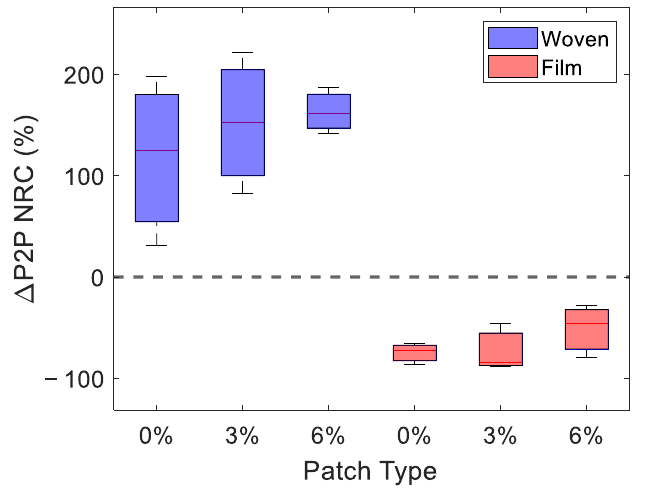
Figure 7. A box plot of the NRC in Δ𝑃2𝑃 , a variable defined to give an indication of the change induced in the skin by one minute of occlusion by the quartz imaging window immediately after the removal of the patches. This figure shows the results in the three subjects who were able to keep the applied pressure within the desired range for the most time points. The red lines inside the boxes indicate the median response observed, while the upper and lower edges of the boxes show the upper and lower quartiles of the measured responses.